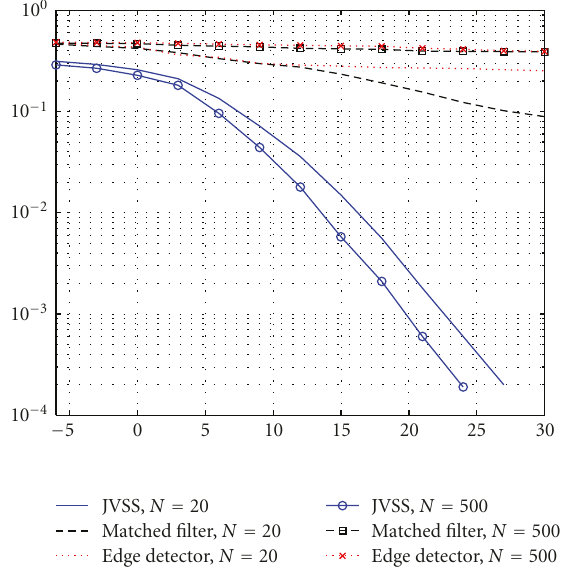
Figure 7: Comparisons of the BERs of the proposed algorithm with high data rate.